Question: Author a descriptive caption for the visualization shown.
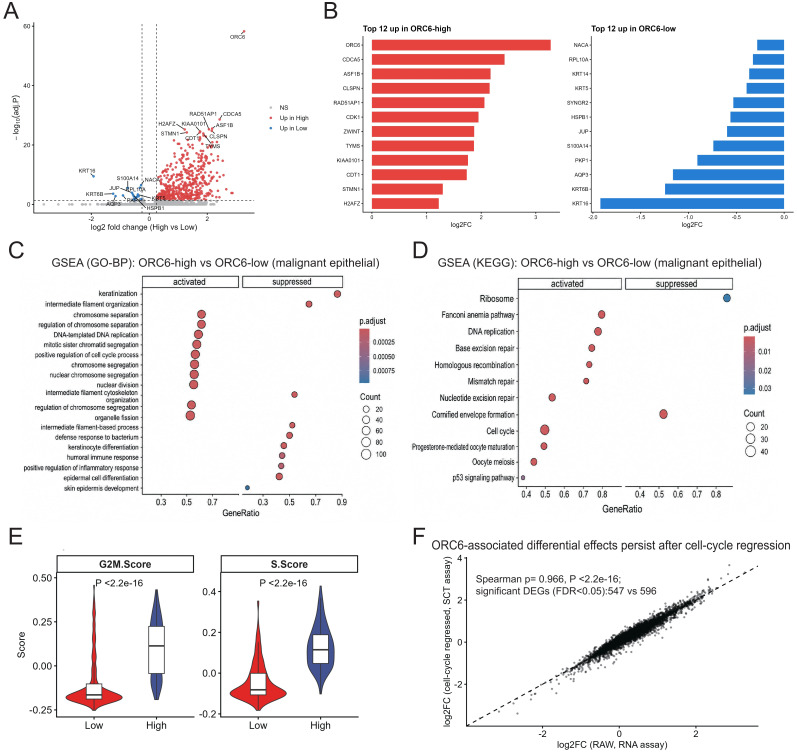
Answer: ORC6 stratification identifies a replication-active malignant epithelial state that remains stable after cell-cycle correction. (A) Volcano plot of differential expression between ORC6-high and ORC6-low malignant epithelial cells. (B) Representative differentially expressed genes. (C) Key enriched pathways summarized from the main analysis; dot size indicates -log10(FDR) and color indicates normalized enrichment score (NES). (D) Donor-paired pseudobulk Hallmark GSEA validation. (E) Comparison of S and G2M scores between ORC6-high and ORC6-low malignant epithelial cells. (F) Concordance of differential effects before and after S/G2M regression. Regression efficacy is shown in Supplementary Figure 6 .